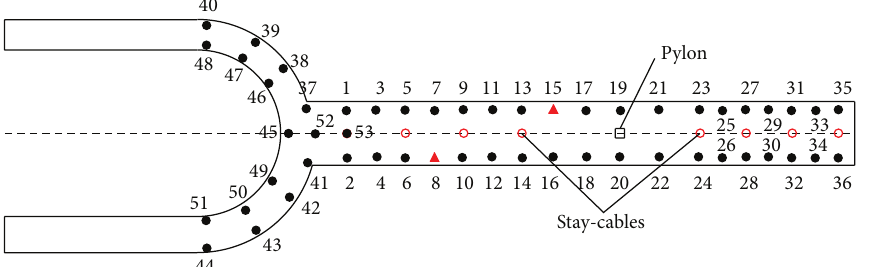
Figure6: Thefootbridge: measurement grid, nodenumbers, andreference locations. (Thetriangles representreference sensorsand thecircles indicate roving